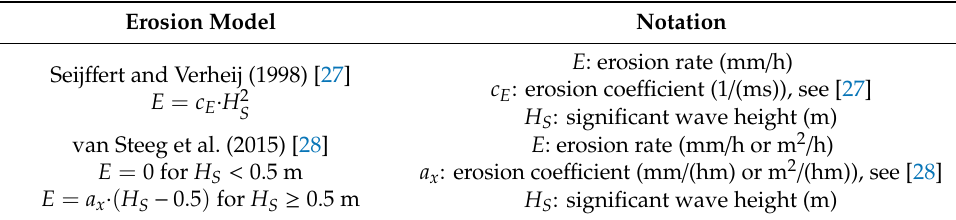
Table 1. Erosion models to describe the erosion on the seaward slope due to wave